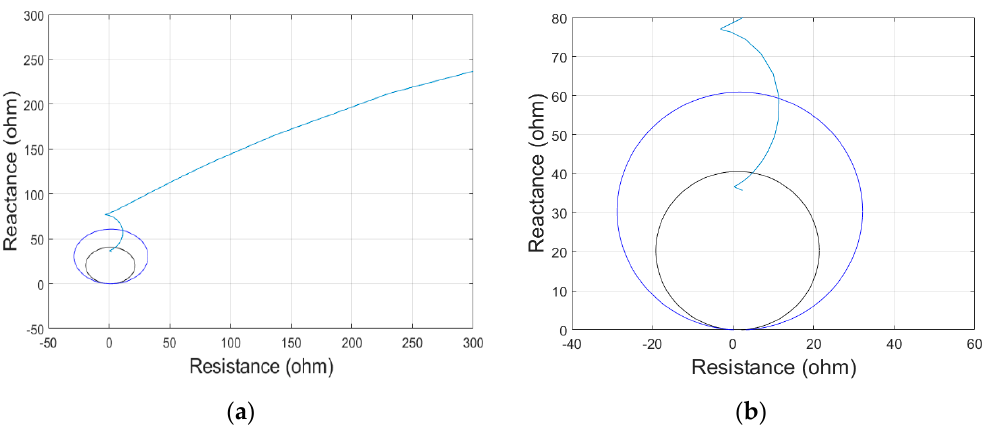
Figure 7. Fault impedance locus for fault at 70 km without time synchronization error. ( a ) locus of distance relay estimating impedance, ( b ) zoom in view of distance relay protection zone.